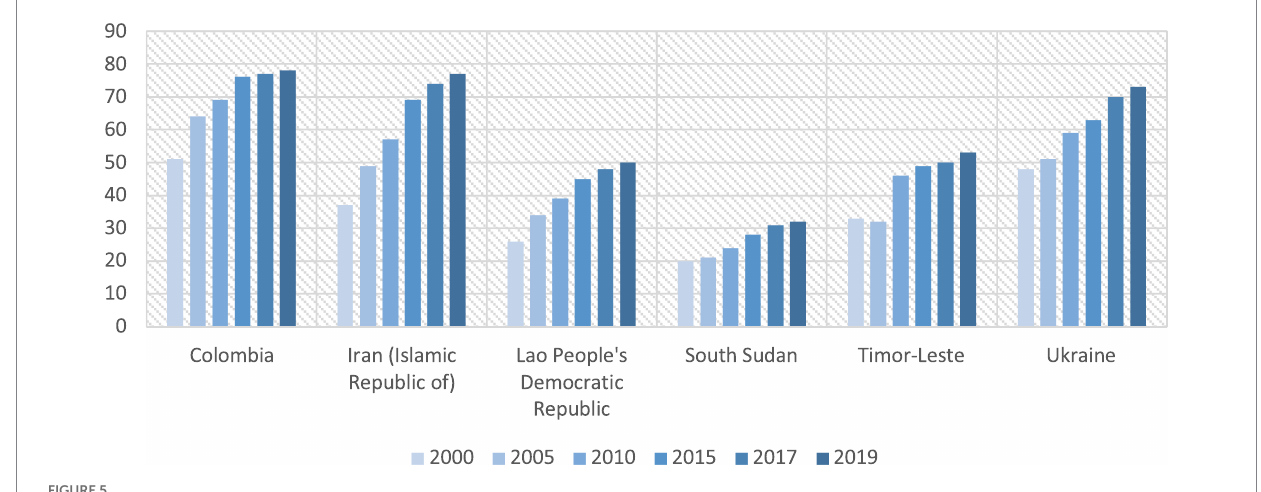
FIGURE 5 Evolution of UHC service coverage index in countries (SDG